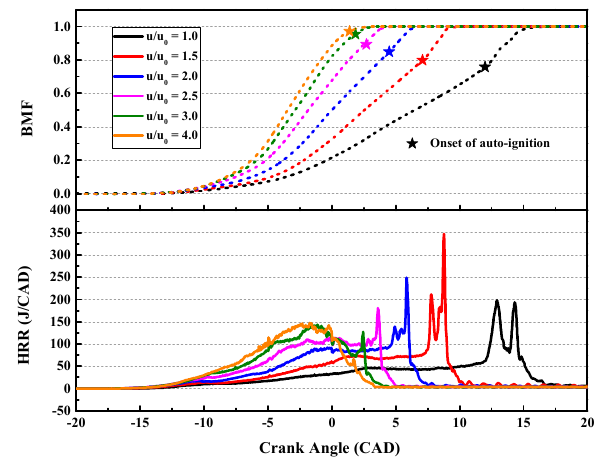
Figure 18. HRR and BMF curves with different turbulence intensities.